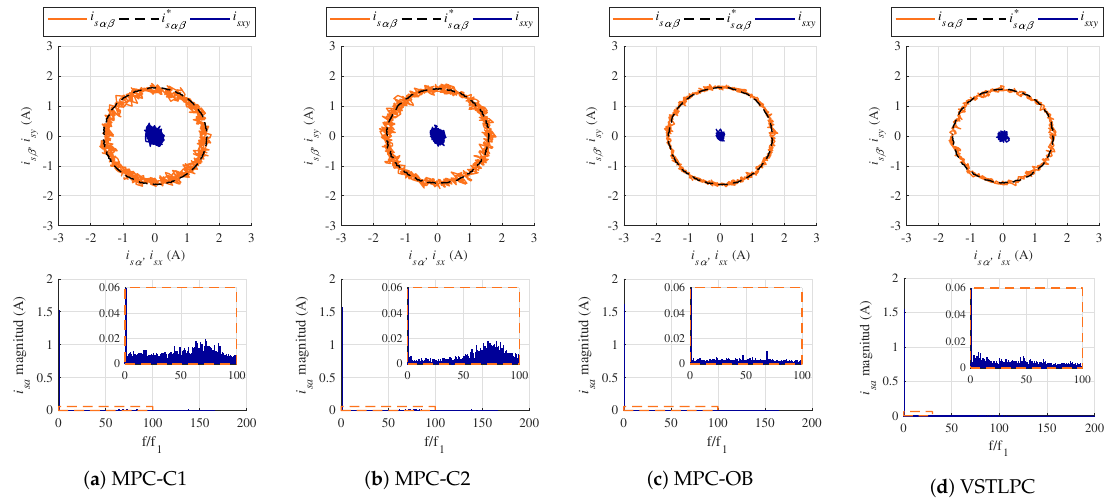
Figure 4. Experimental steady-state test for 100 rpm and a load torque of 60% of the nominal one. Upper plots present the α – β and x – y current trajectories, and the lower plots present the a -current spectrum.